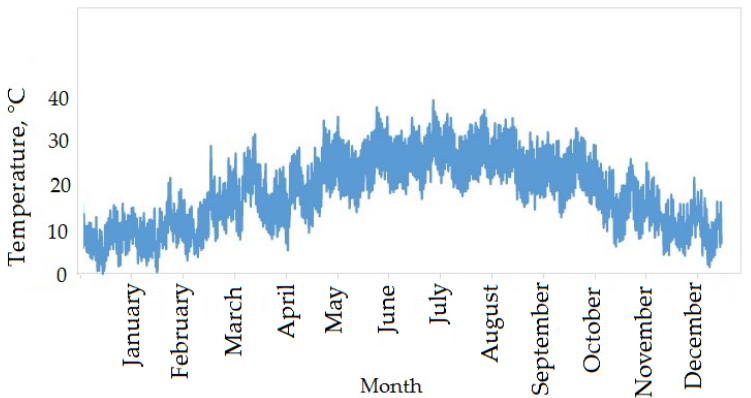
Figure 3. Daily ambient temperature at German Jordanian University (GJU) campus.